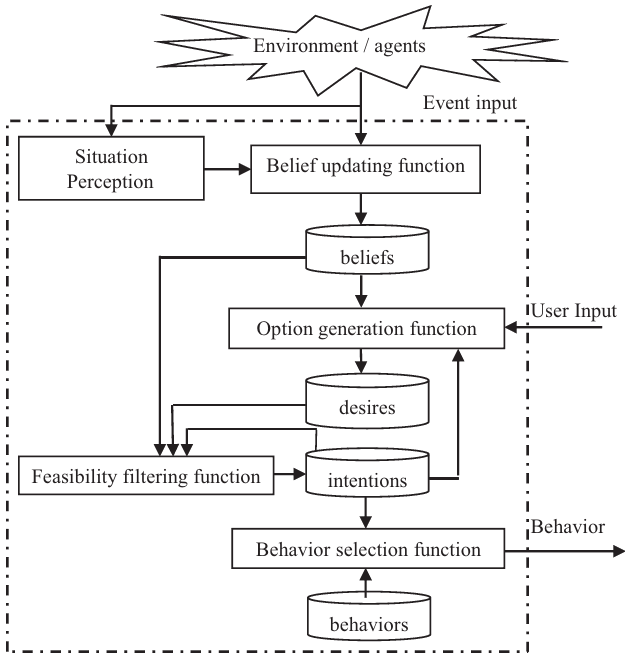
Figure 5. BDI model based individual agent behavior design.